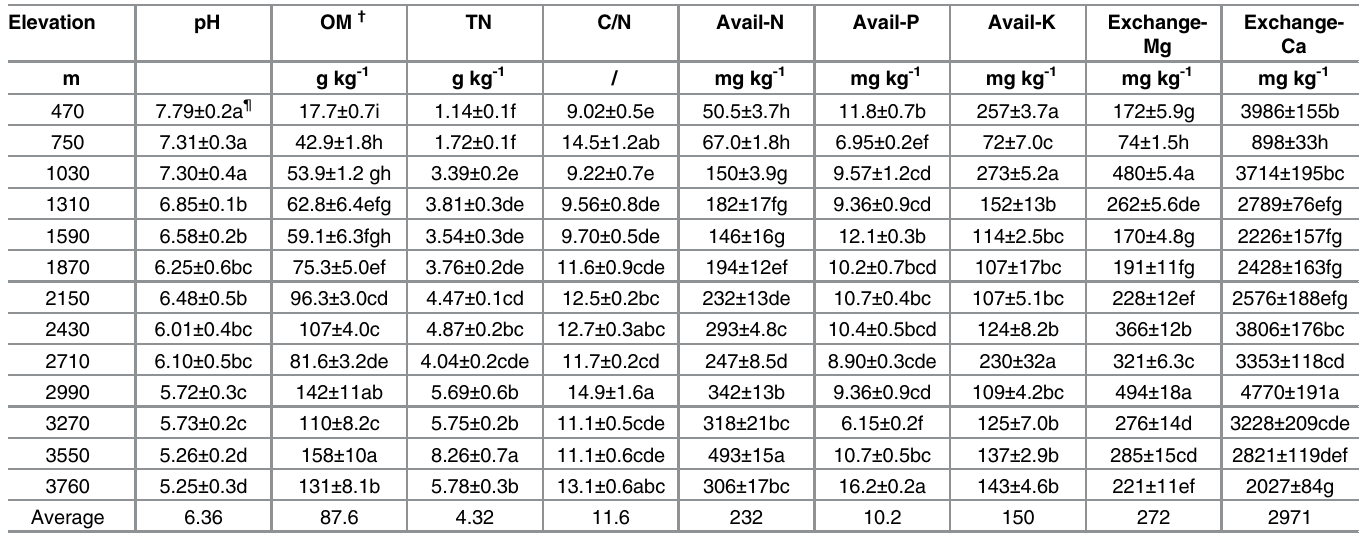
Table 1. Basic soil properties along the elevational gradient of Taibai Mountain. Values represent the mean ± SE (standard error), n =